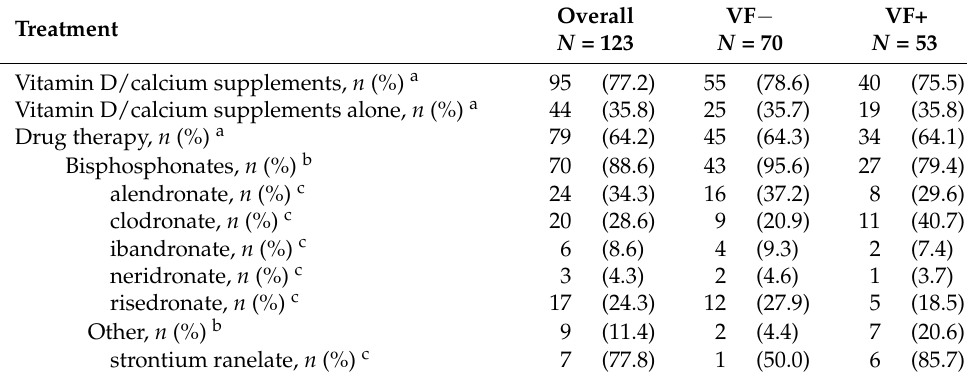
Table 2. Osteoporosis medications.